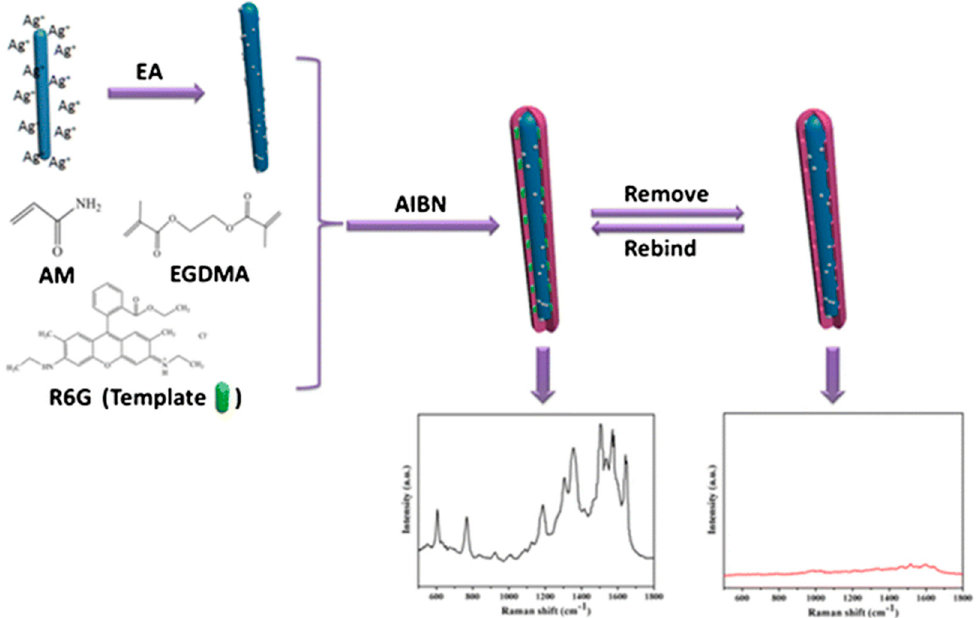
Figure 6. Preparation of the ZnO / Ag molecularly imprinted polymers (ZOA-MIPs) and the selective surface-enhance Raman scattering (SERS) detection of rhodamine 6G (R6G). AIBN: 2,2 ′ -azobis(2-methylpropionitrile); AMm: acrylamide; EA: ethanolamine; EGDMA: ethylene glycol dimethacrylate. Reproduced from [105] with permission of Springer.